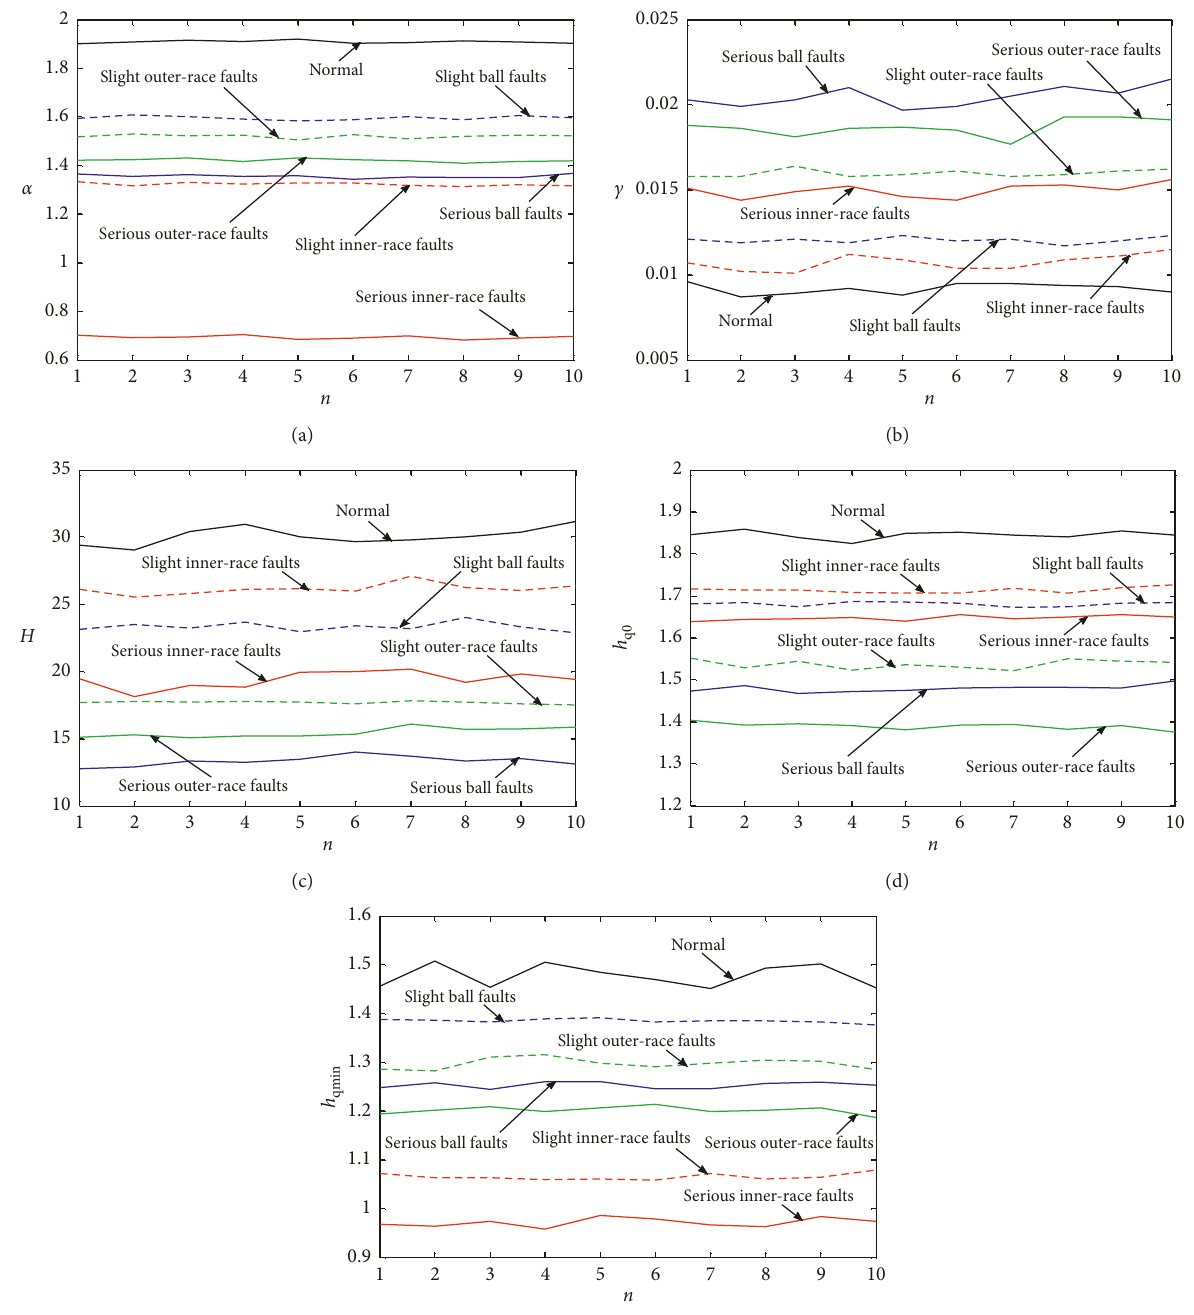
Figure 12: The stability and sensitivity of the five fault characteristic parameters of seven signals. (a) α . (b) c . (c) H . (d) h Table 4: The primary parameters of PSO. Parameter Value Primary position and its increment vector Generate randomly Population size 40 Maximum iteration number 200 Accelerating coefficients c 1 and c 2